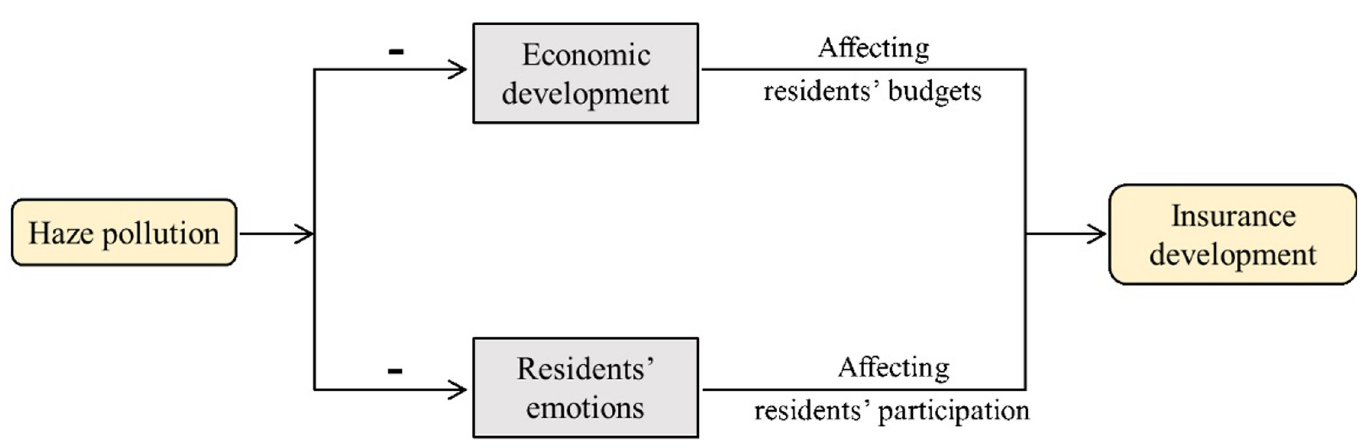
Fig 2. The transmission mechanisms of the effect of haze pollution on insurance development.